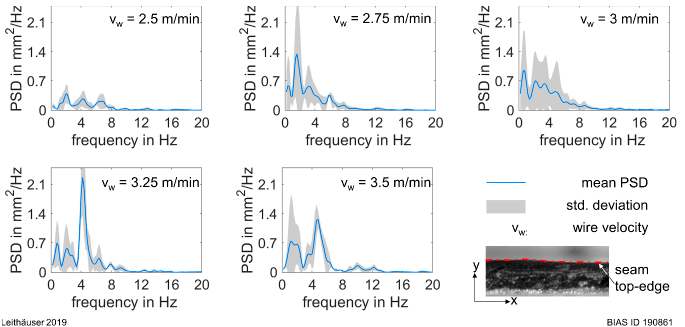
Figure 12. Mean PSDs and standard deviations of the wetting front for wire feed rates between 2.5 and 3.5 m/min.